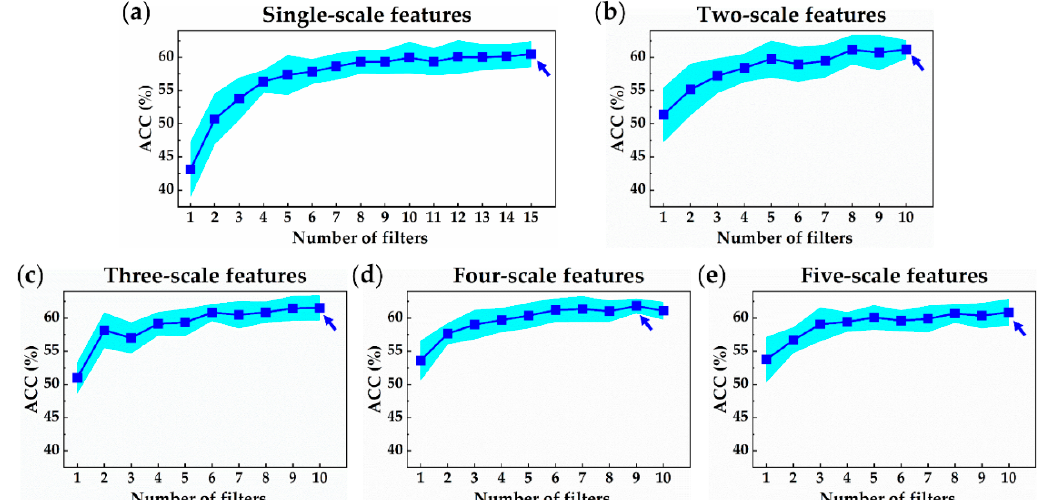
Figure 8. Accuracy trends of our proposed MI locating models plotted in shaded error bar. Blue- and gray-shaded areas indicate the range of one standard deviation and best average accuracy under the same scale number are marked by an arrow: Accuracy of models using ( a ) single-scale features, ( b ) two-scale features, ( c ) three-scale features, ( d ) four-scale features, and ( e ) five-scale features.